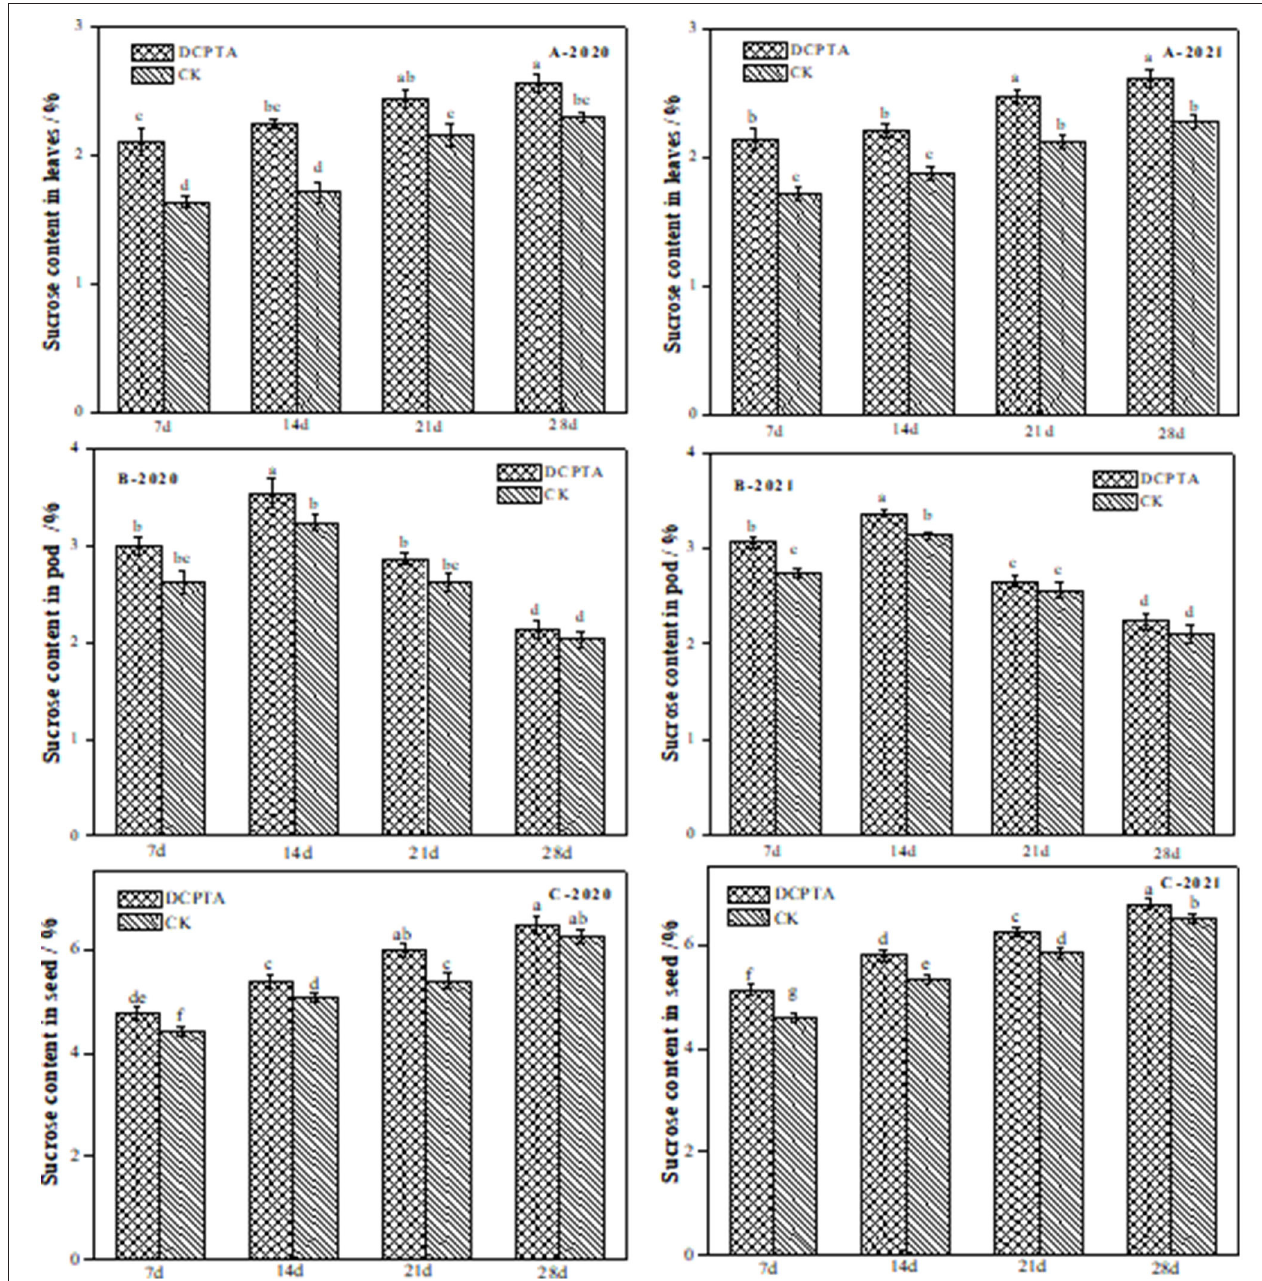
FIGURE 7 | Effects of DCPTA on sucrose content in leaves, pods, and grain from 2020 to 2021. (A) Sucrose content in leaves; (B) Sucrose content in pods; (C) Sucrose content in grain at 7–28 days after spraying in 2020 and 2021. Data were analyzed by ANOVA to separate significance. Vertical bars represent mean ± SE from three independent replicates and the different letters denote significant differences ( p <